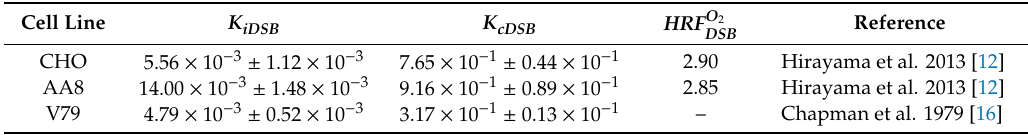
Table 1. Model parameters derived from cell survival data of three cell lines irradiated with di ff erent DMSO concentrations and in hypoxic condition when available.